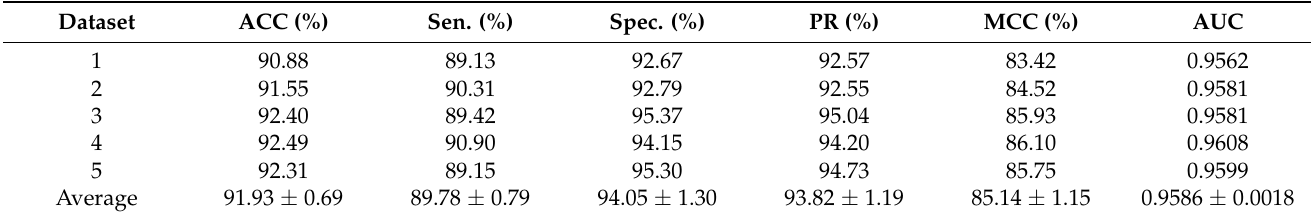
Table 1. Five-fold CV results performed by the proposed model on the Yeast PPIs dataset.